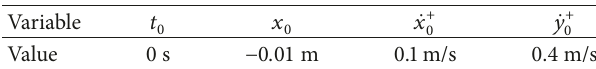
Table 2: Initial system state variables.